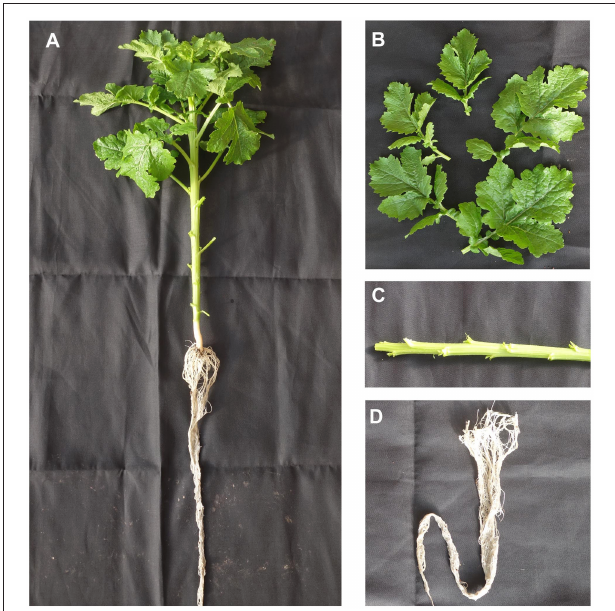
FIGURE 1 | Plants and sampling. (A) Whole plant for sampling. (B) Leaf sample. (C) Stem sample. (D) Root sample.